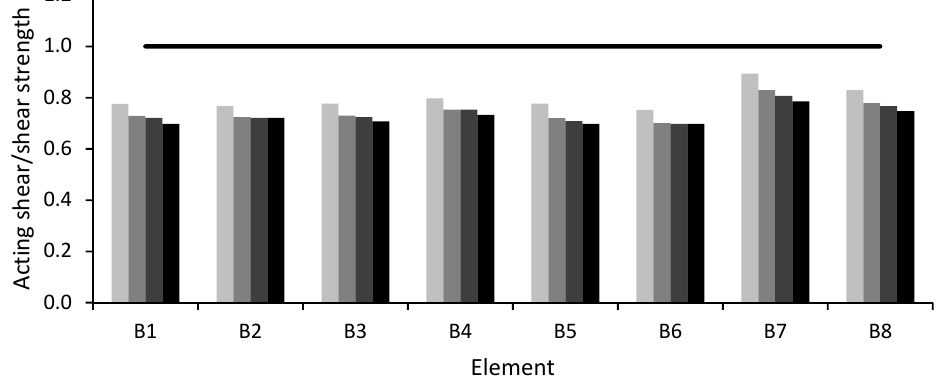
Figure 16. Shear verifications of beams in as-built conditions.